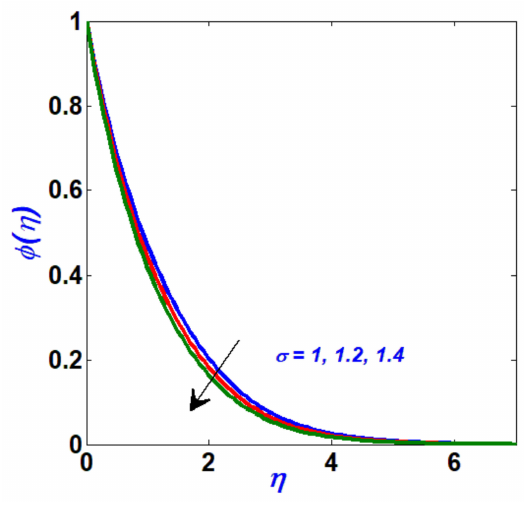
Figure 15. Concentration profile with variation in σ .